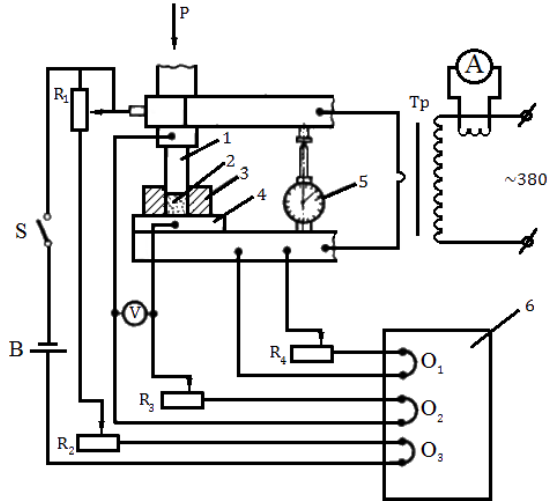
Figure 13. A set-up to record shrinkage during electric pulse sintering: R R , R —rheostats; V—voltmeter; Тp—transformer; А—ammeter; O 3 4 probes; B—current source; S—switch; 1—movable punch; 2—powder compact; 3—die; 4—fixed punch; 5—dial indicator; and